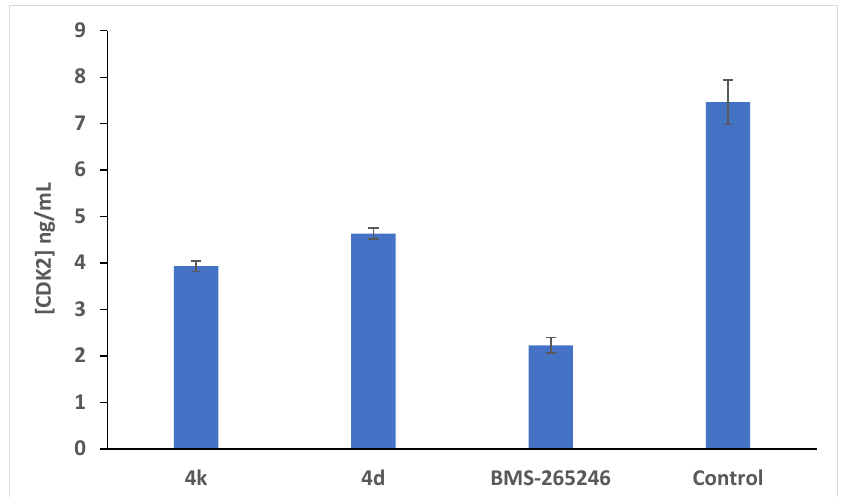
Figure 17. In vitro quantitative determination of the concentrations of CDK2 (ng/mL) in HCT116 cells treated with pyrans 4d and 4K compared with the positive control BMS-265246 and the negative control samples.